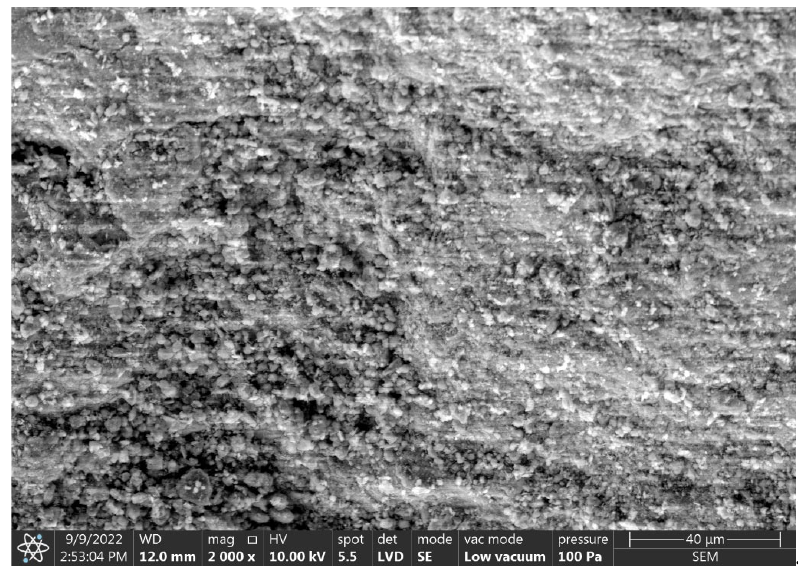
Figure 15. SEM images of the C ‐ 2 agglomerate surface.